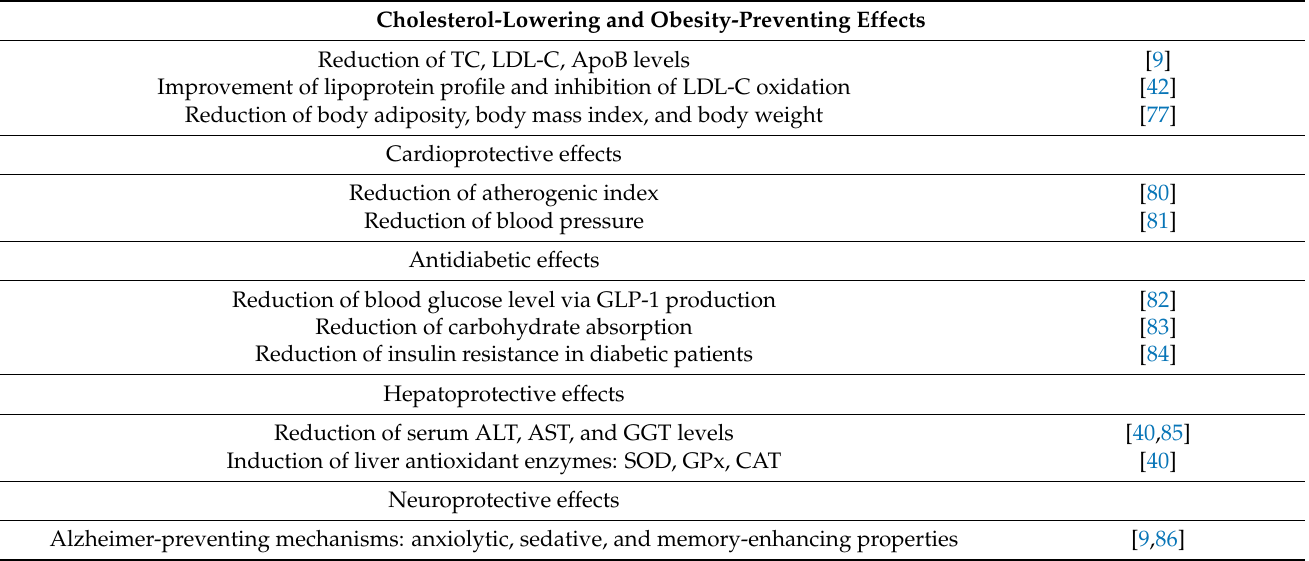
Table 4. Health-promoting effects of almond and its by-products on chronic diseases. Cholesterol-Lowering and Obesity-Preventing Effects Reduction of TC, LDL-C, ApoB